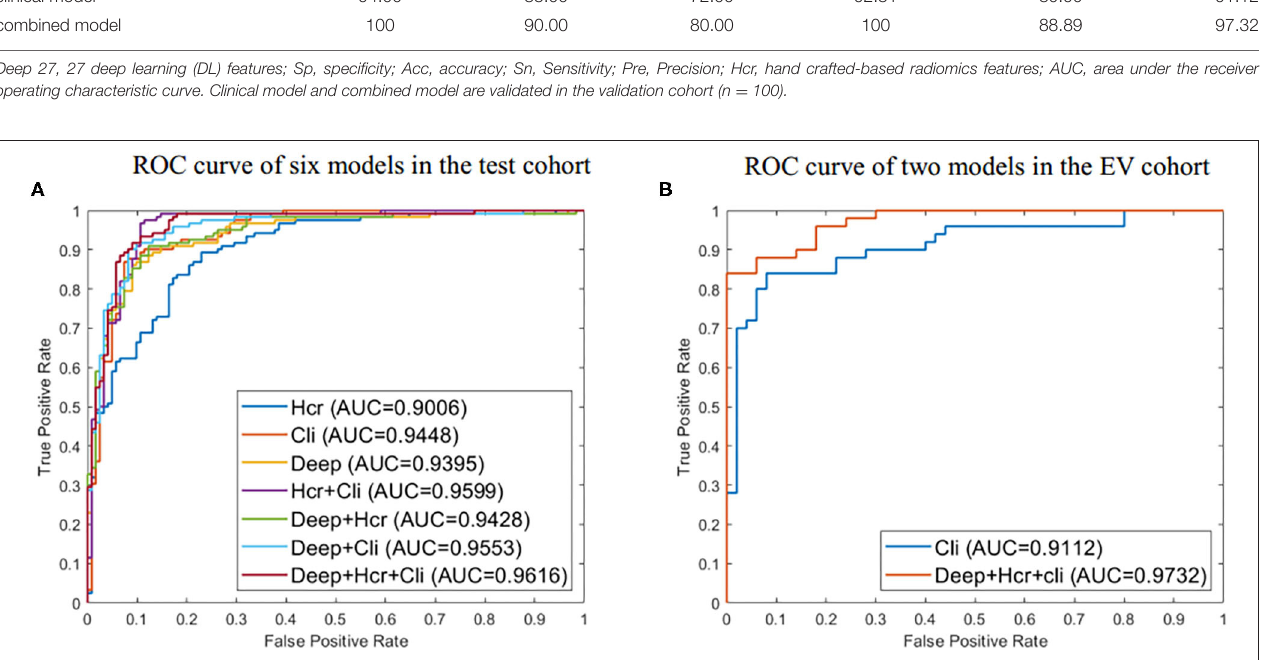
FIGURE 4 | (A) ROC curve for evaluated predictive performance of seven methods in test cohort. (B) ROC curve for evaluated predictive performance of the external validation (EV) set. Deep represents 27 deep learning (DL) features. Hcr, hand crafted-based radiomics features; Cli,